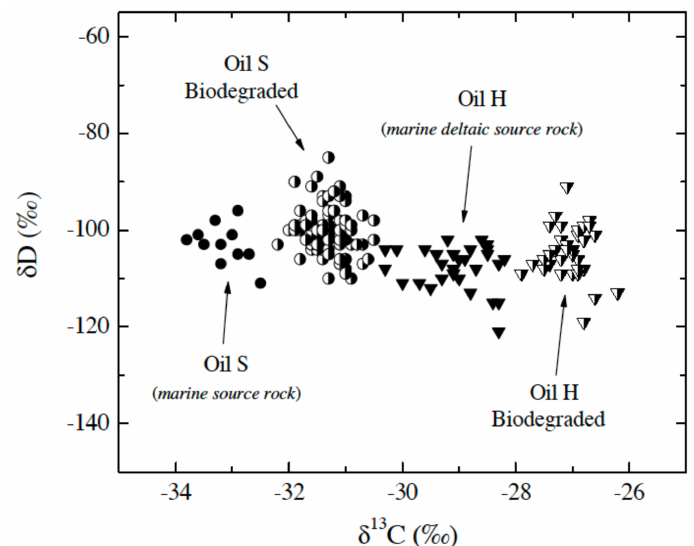
Figure 4. A cross plot of δ 13 C and δ D values of all n -alkanes for which both types of isotope data were acquired. Normal alkanes from Oil S correspond to sample #1a, n -alkanes from Oil S Biodegraded to samples #1b, 1c, 1d, 1e, 1f, 1g and 1h, respectively. Normal alkanes from Oil H correspond to samples #2a and 2b, and n -alkanes from Oil H Biodegraded to samples #2c, 2d and 2e, respectively.